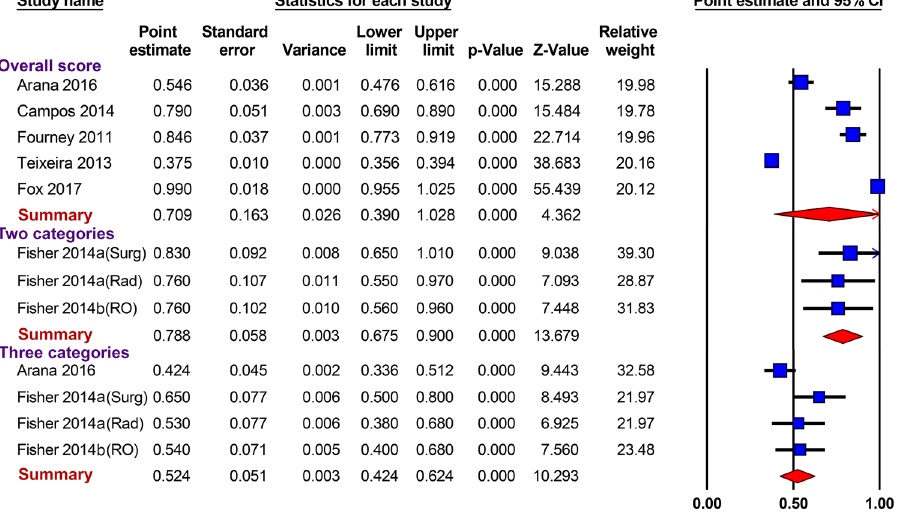
Figure 4. Forest plots of interobserver reliability ( κ -values). The summary estimates of the interobserver reliability were 0.709 for the overall score, 0.788 when 2 categories were used, and 0.524 when 3 categories were used. Despite the small number of studies, the results of the studies were highly consistent, with a low standard deviation. This figure was drown using the comprehensive Meta-Analysis software version 3.3.